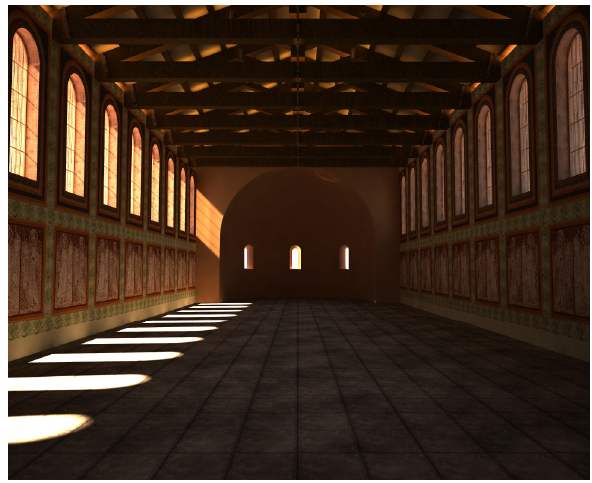
Figure 7. Interior reconstruction of VI century.